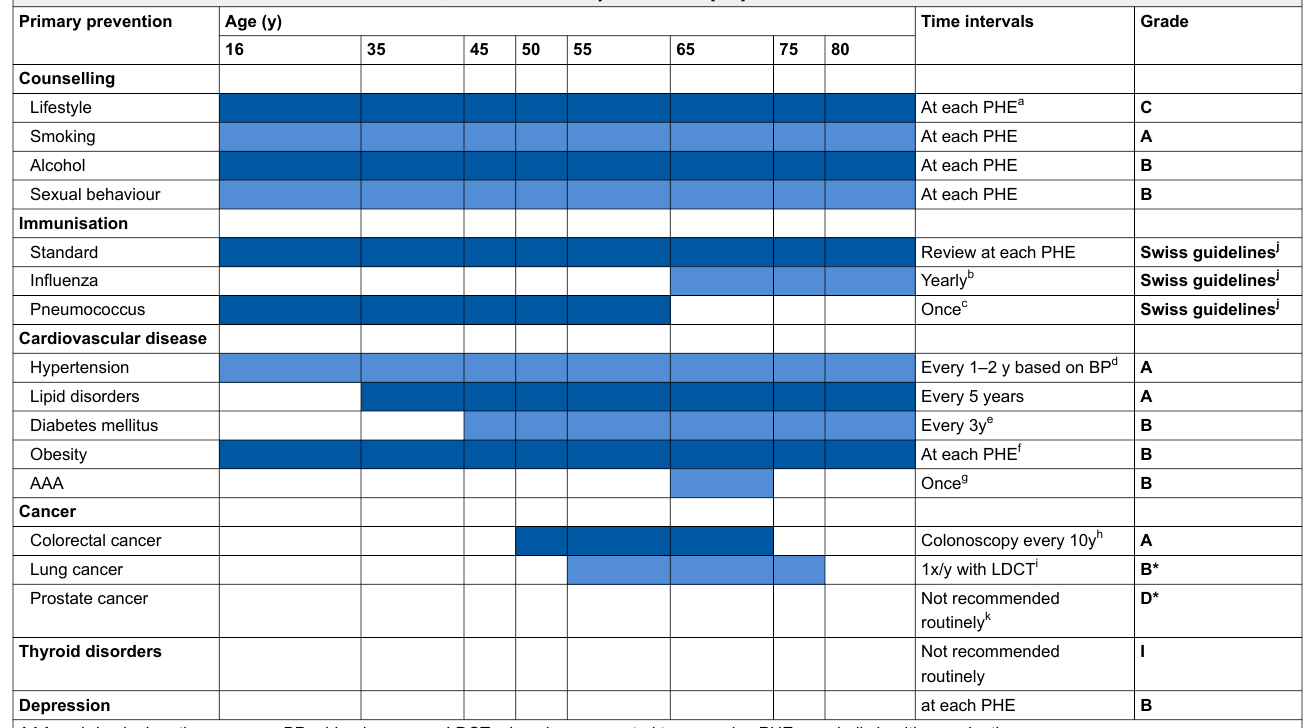
Table 1: Preventive care services recommended for men, as recommended by the USPSTF